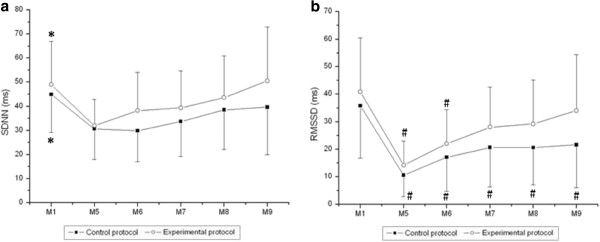
Values are means ± standard deviation. SDNN (a) and RMSSD (b) during recovery and the comparison in control and experimental protocols. Final 5 minutes of rest (M1) and minutes of recovery: 5th to 10th (M5), 15th to 20th (M6), 25th to 30th (M7), 40th to 45th (M8), 55th to 60th (M9). *Different from M5, M6, M7, M8 and M9 (p<0.05). #Different from M1 (p<0.05).